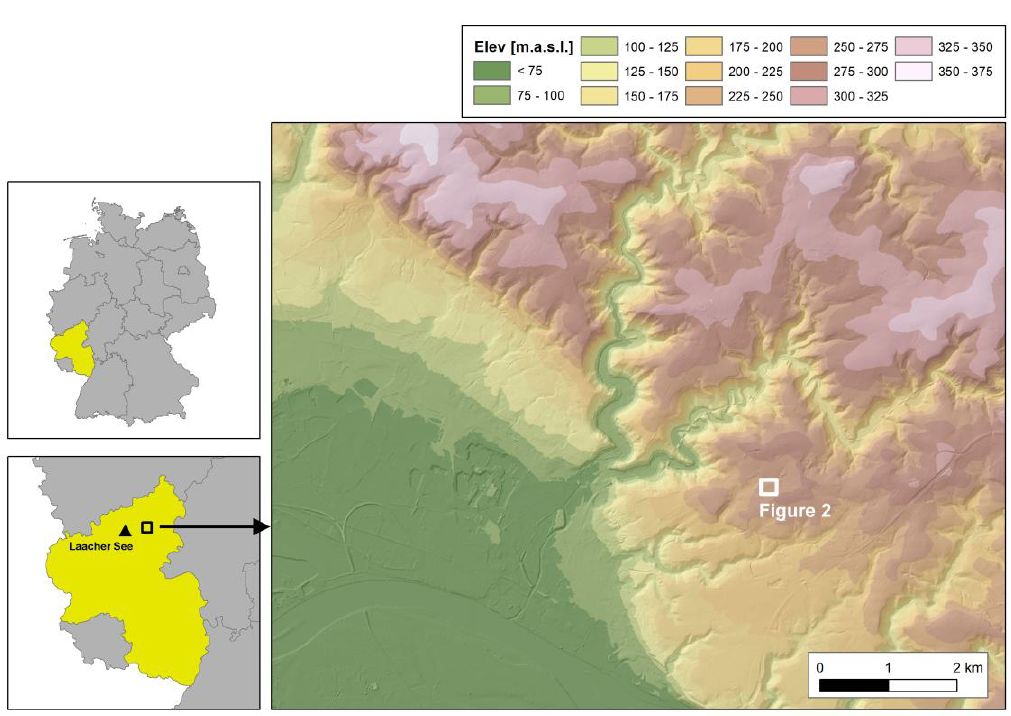
Figure 1. Location of the study area (after [37,48]).